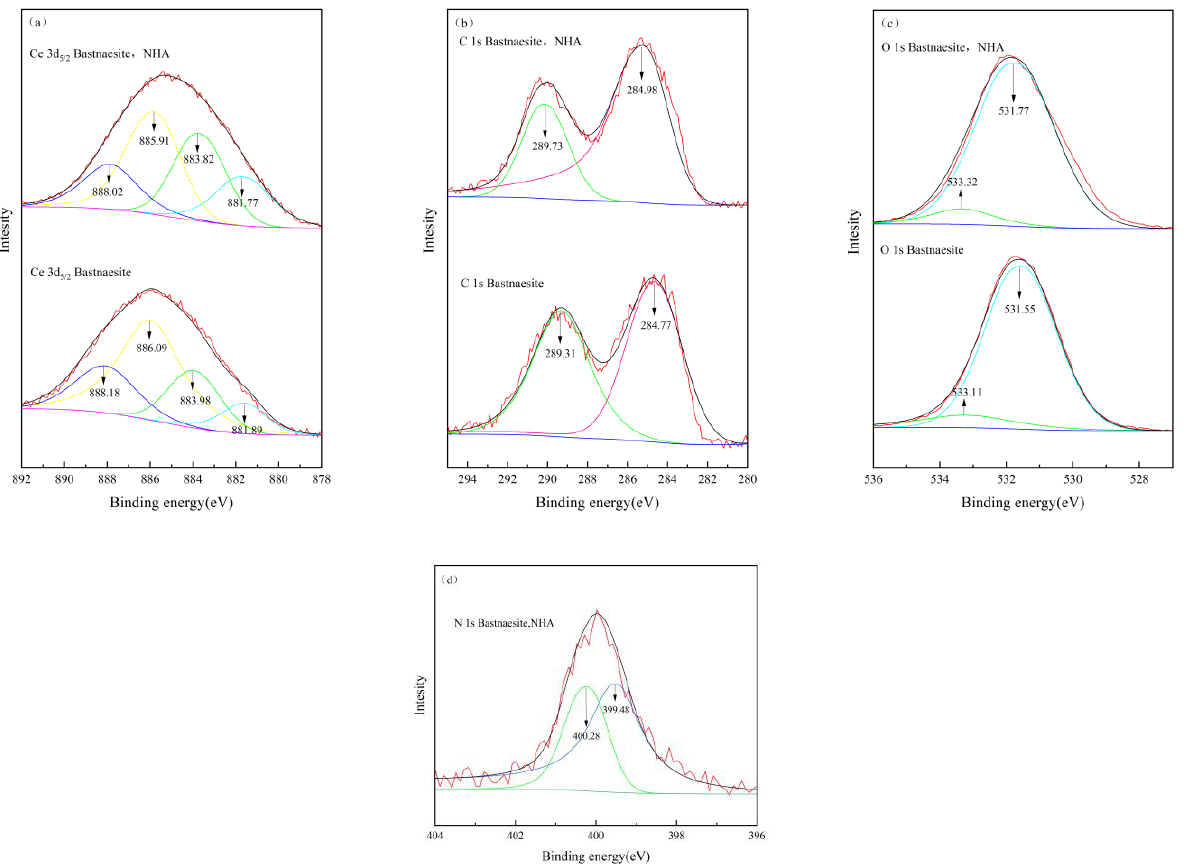
Figure 8. High-resolution XPS spectra of Ce 3d5/2 ( a ), C 1 s ( b ), O 1 s ( c ) and N 1 s ( d ) of pure and NHA-treated bastnaesite particles, respectively. Table 7. Analysis results of Ce 3d5/2 XPS spectra of bastnaesite samples untreated and treated with NHA.